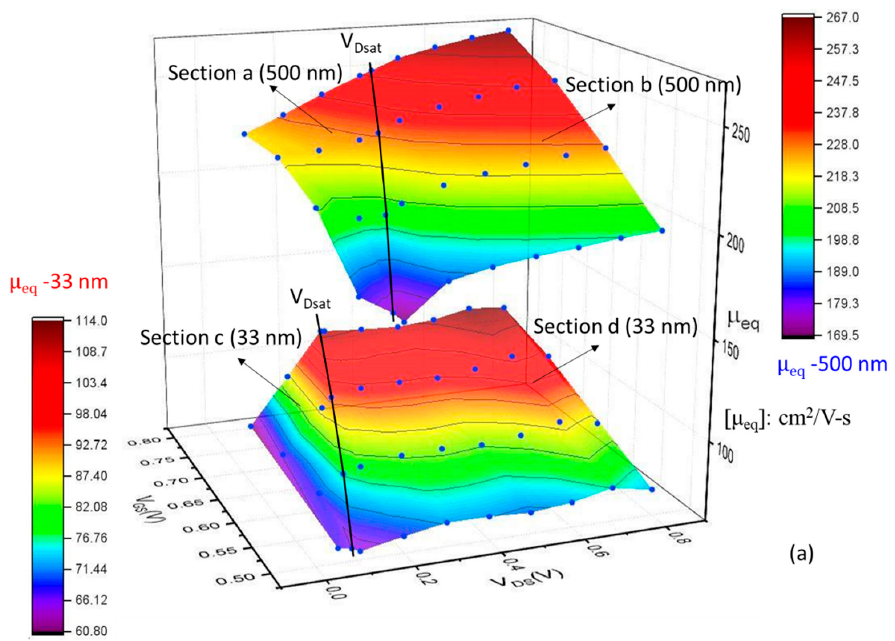
Figure 7. I DS vs. V DS curves for long-channel devices: ( a ) at L mask = 1 μ m in section X = a , and ( b ) at L mask = 500 nm in section X = b ; for short-channel devices: ( c ) at L mask = 50 nm in section X = c , and ( d ) at L mask = 33 nm in section X = d . The yellow lines mean the pinch-off boundary at V Dsat = V GS − V T , where V T is the threshold voltage.